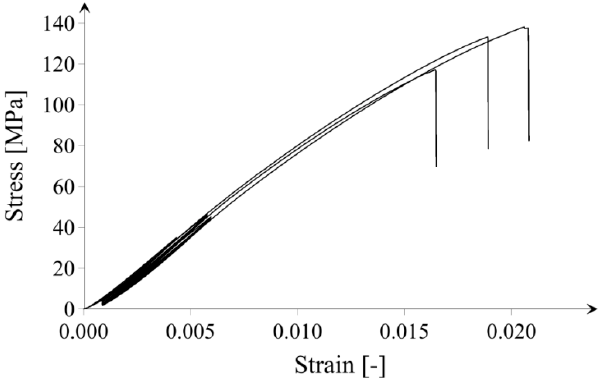
Figure 8. Results of compressive strength (f c ) of all tested series. Vertical bars indicate one standard deviation.